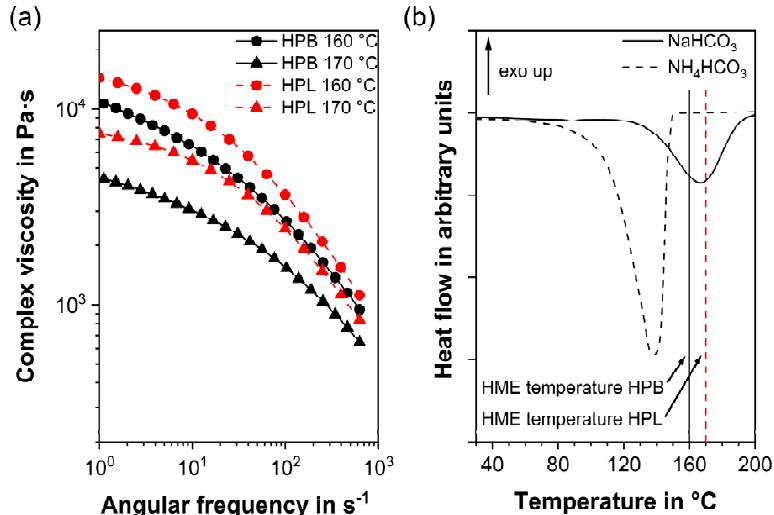
Figure 1. ( a ) Mean viscosity curves of three individual measurements for the hydrophobic (HPB) and hydrophilic thermoplastic polyurethane (HPL) at their recommended hot-melt extrusion temperatures and ( b ) di ff erential scanning calorimetry thermograms of the pore formers with the characteristic endothermic decomposition peaks of the carbonate-based pore